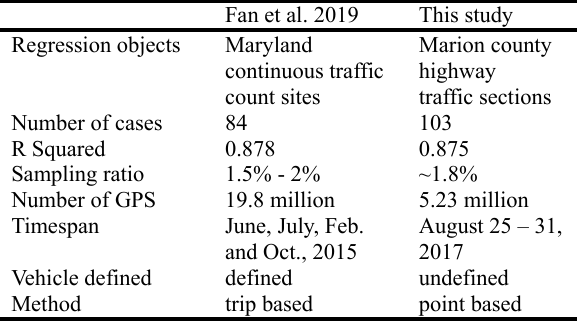
Table 1 Comparison of data and methods between Fan et al. (2019) and this